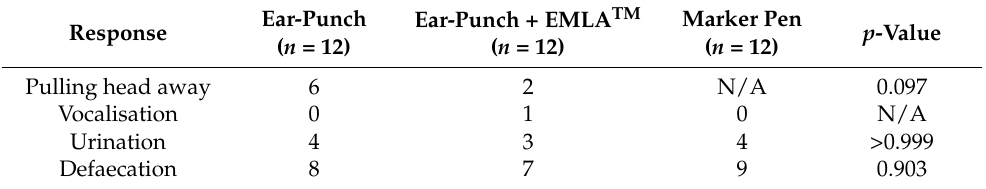
Table 2. Number of mice showing behavioural responses during treatment procedure. There were no significant differences between treatment groups ( n = 12/group).